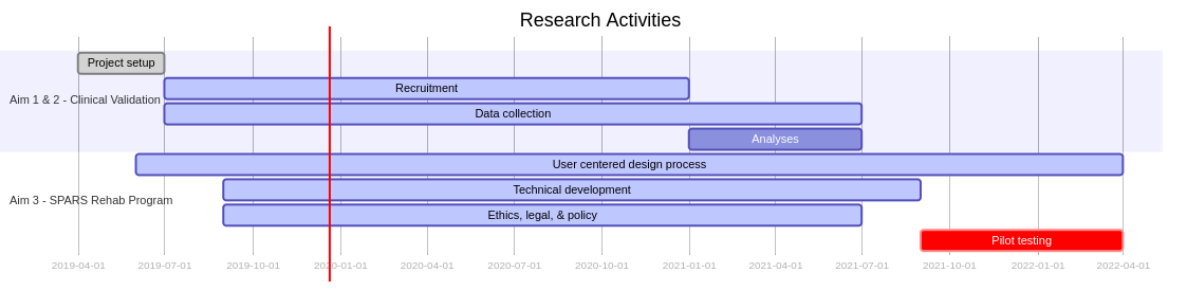
Figure 1. Study timeline. SPARS: Smart Physiotherapy Activity Recognition